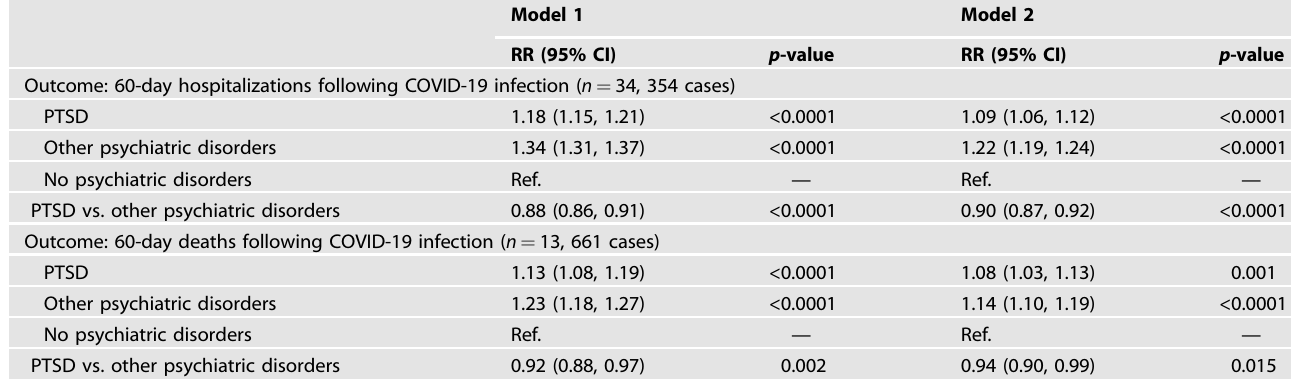
Model 1: age, age squared, sex, race, and ethnicity. Model 2: Model 1 plus obese status, diabetes, cardiovascular disease including hypertension, obstructive sleep apnea, chronic obstructive pulmonary disease, cancer, chronic kidney disease, liver disease, human immunode fi ciency virus, and smoking. RR relative risk, CI con fi dence intervals, PTSD post-traumatic stress